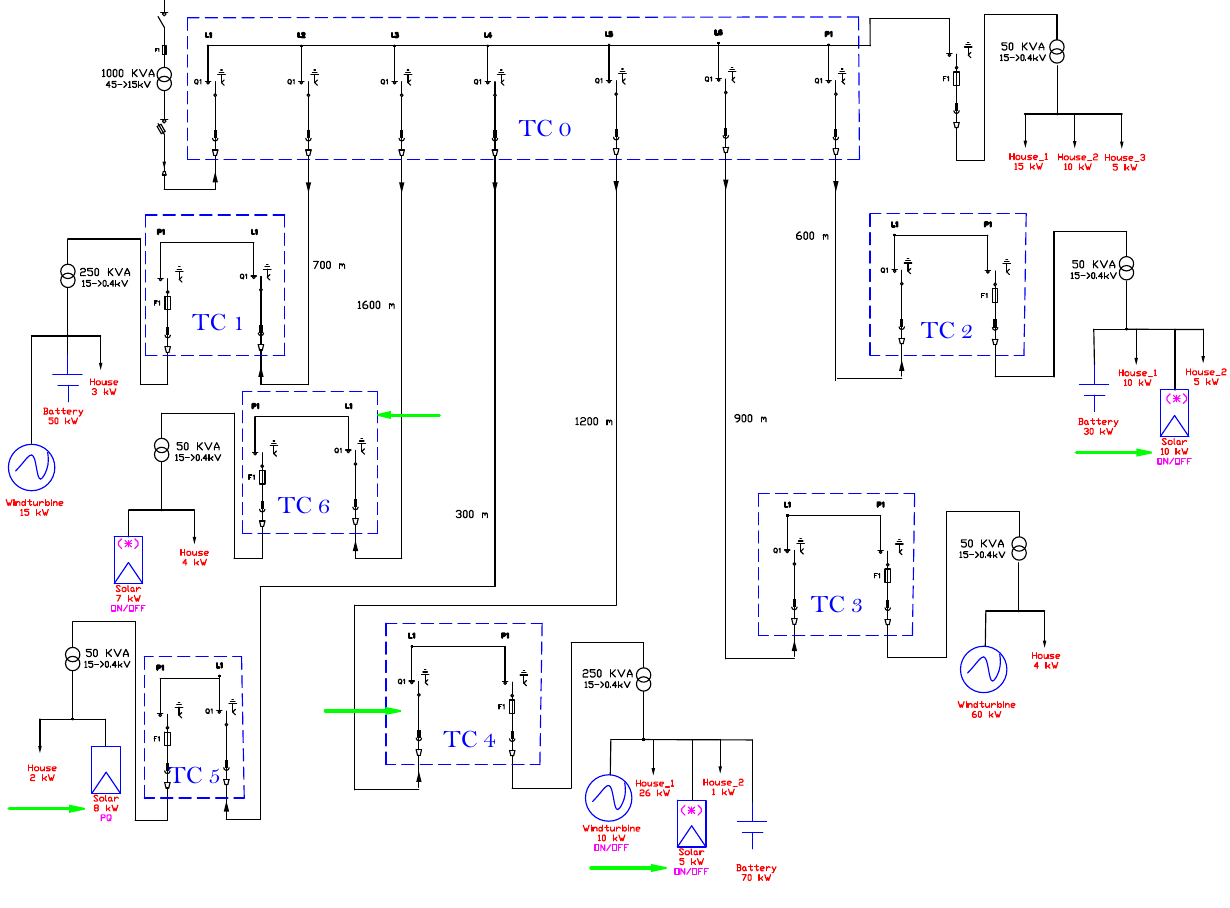
Figure 8. Microgrid to be controlled by